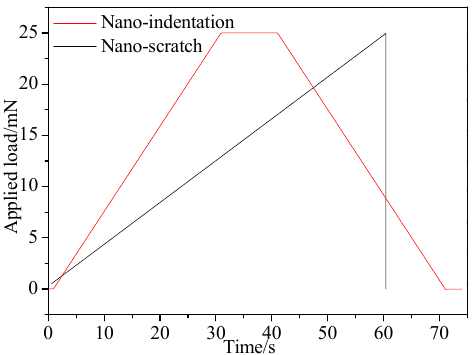
Figure 3. Loading-unloading curves of nano-indentation and nano-scratching.